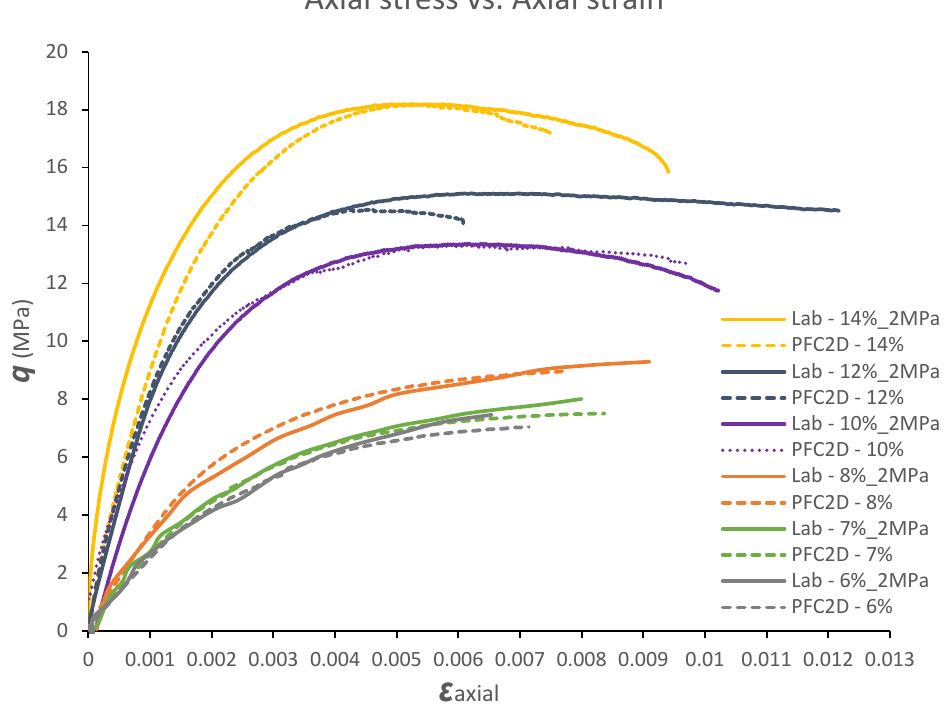
Figure 2. Comparison of the triaxial test results from the laboratory experiments and DEM simulations.